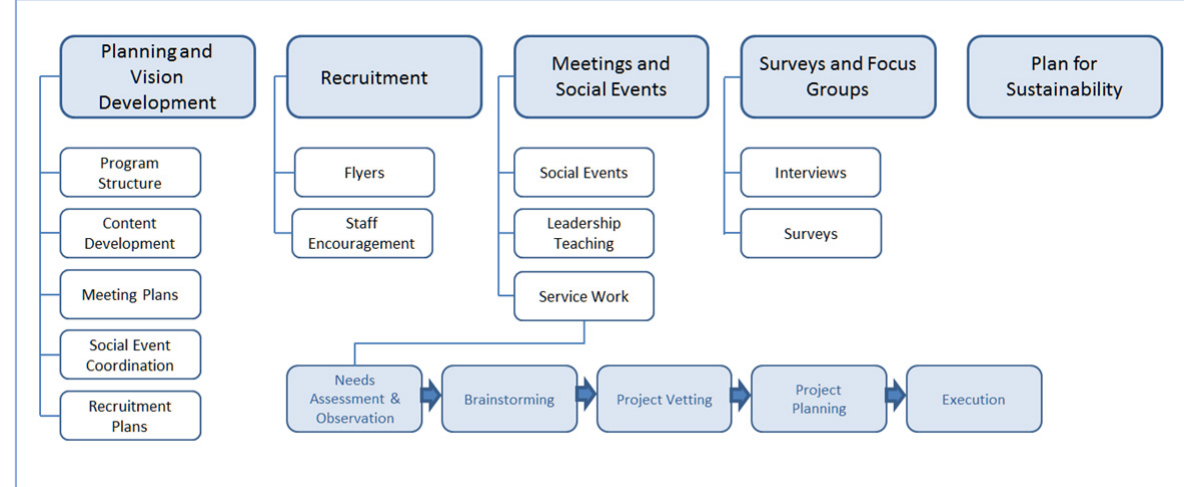
Figure 1. Program Model—BLAST (Building Leaders Around Successful Thinking)